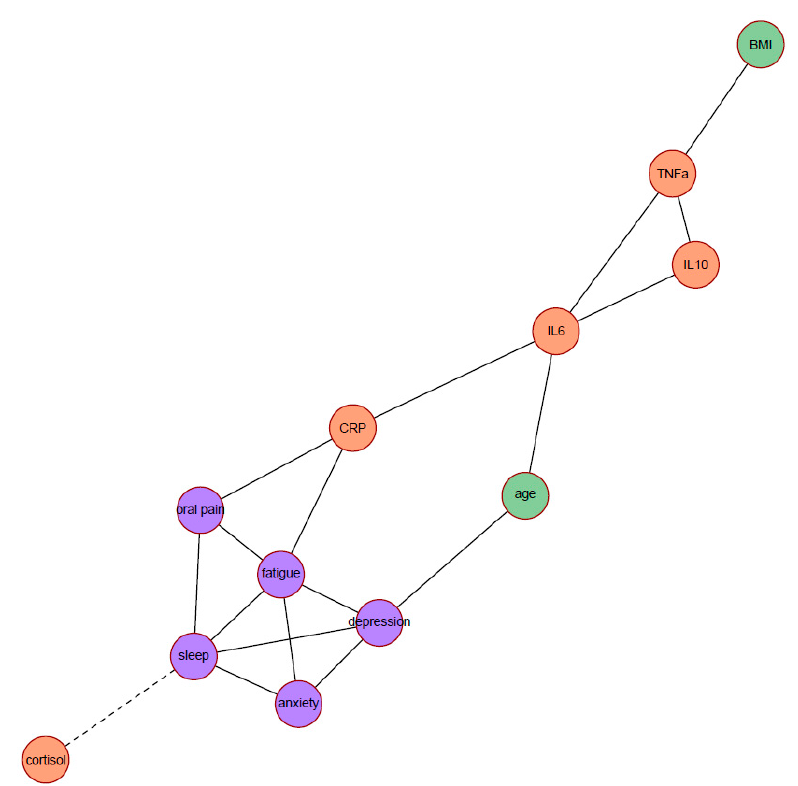
Figure 1. Network displaying the partial correlations between all symptoms (in purple), biomarkers (in salmon orange), and covariates (in green); N = 264. Solid edges represent positive partial correlations, dashed edges represent negative partial correlations. The anxiety label indicates the HADS anxiety subscale score; depression, HADS depression subscale score; fatigue, MFI general fatigue score; oral pain, EORTC QLQ-H&N35 oral pain subscale score; sleep, PSQI total score; and cortisol, the diurnal cortisol slope. Abbreviations: BMI, body mass index; CRP, c-reactive protein; IL, interleukin; TNF- α , tumor necrosis factor alpha.